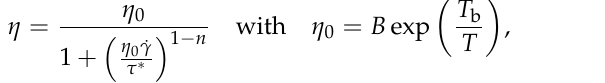
Figure 2. Average of the norm of complex dynamic viscosity rate ˙ γ of the VE matrix at T = 25 ◦